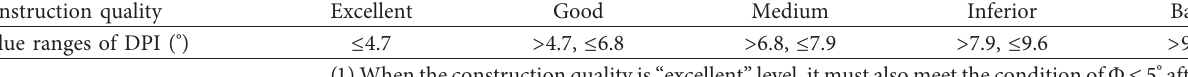
Table 12: Evaluation standard of construction quality for asphalt pavement based on DPI. Construction